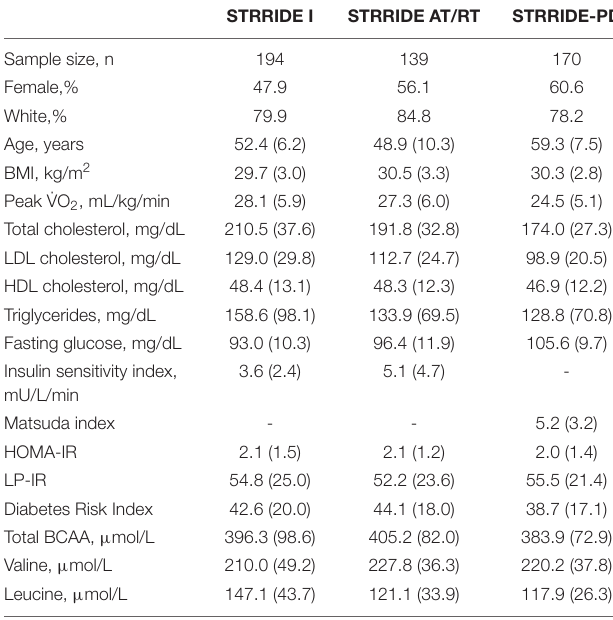
TABLE 1 | Baseline characteristics for STRRIDE I, STRRIDE AT/RT, and STRRIDE-PD